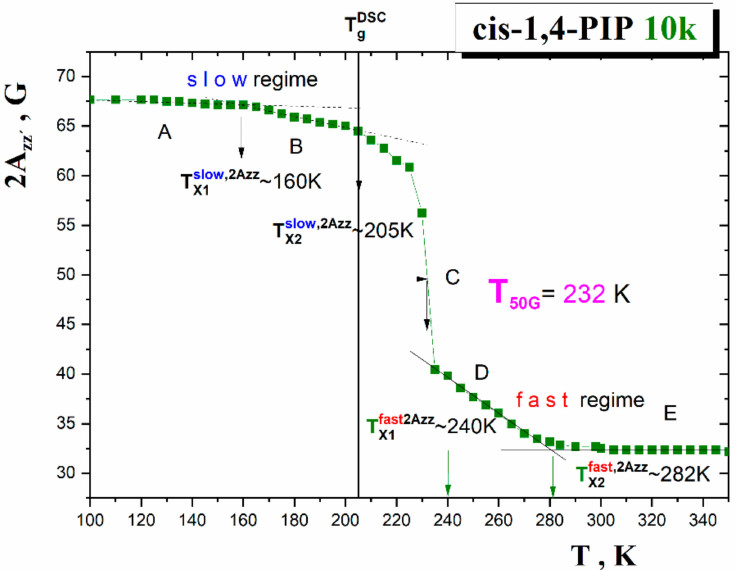
Figure 2. The distance of the outer line separation of spectra, 2 A zz (cid:48) , as a function of temperature for TEMPO mobility in cis -1,4-PIP10k. Two weak decreases at T X1slow,2Azz~ 160 K and T X2slow,2Azz~ 205 K within the slow motion regime followed by the main transition of spin probe reorientation from the slow to fast motion regime at T 50G = 232 K and finally, by the onset and crossover effects within the fast regime at T X1fast,2Azz~ 240 K and T X2fast,2Azz~ 282 K occur. The glass-to-liquid transition temperature T gDSC is also included by vertical